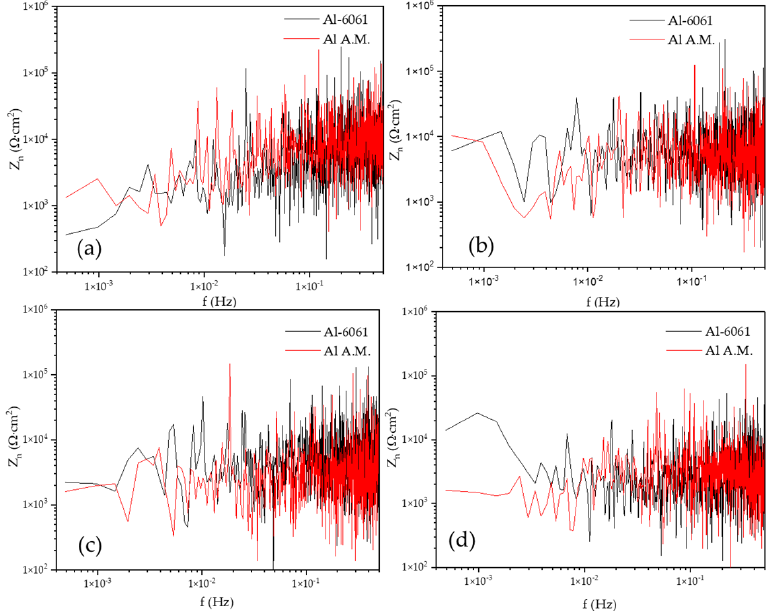
Figure 11. Noise impedance in NaCl solution, ( a ) 0 h, ( b ) 24 h, ( c ) 48 h, ( d ) 120